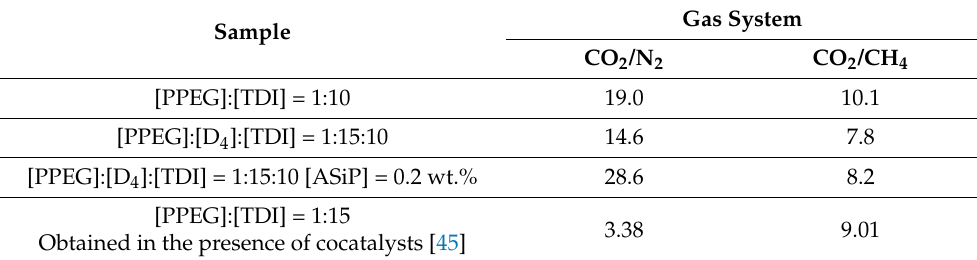
Table 3. Ideal selectivity for CO 2 /gas systems.